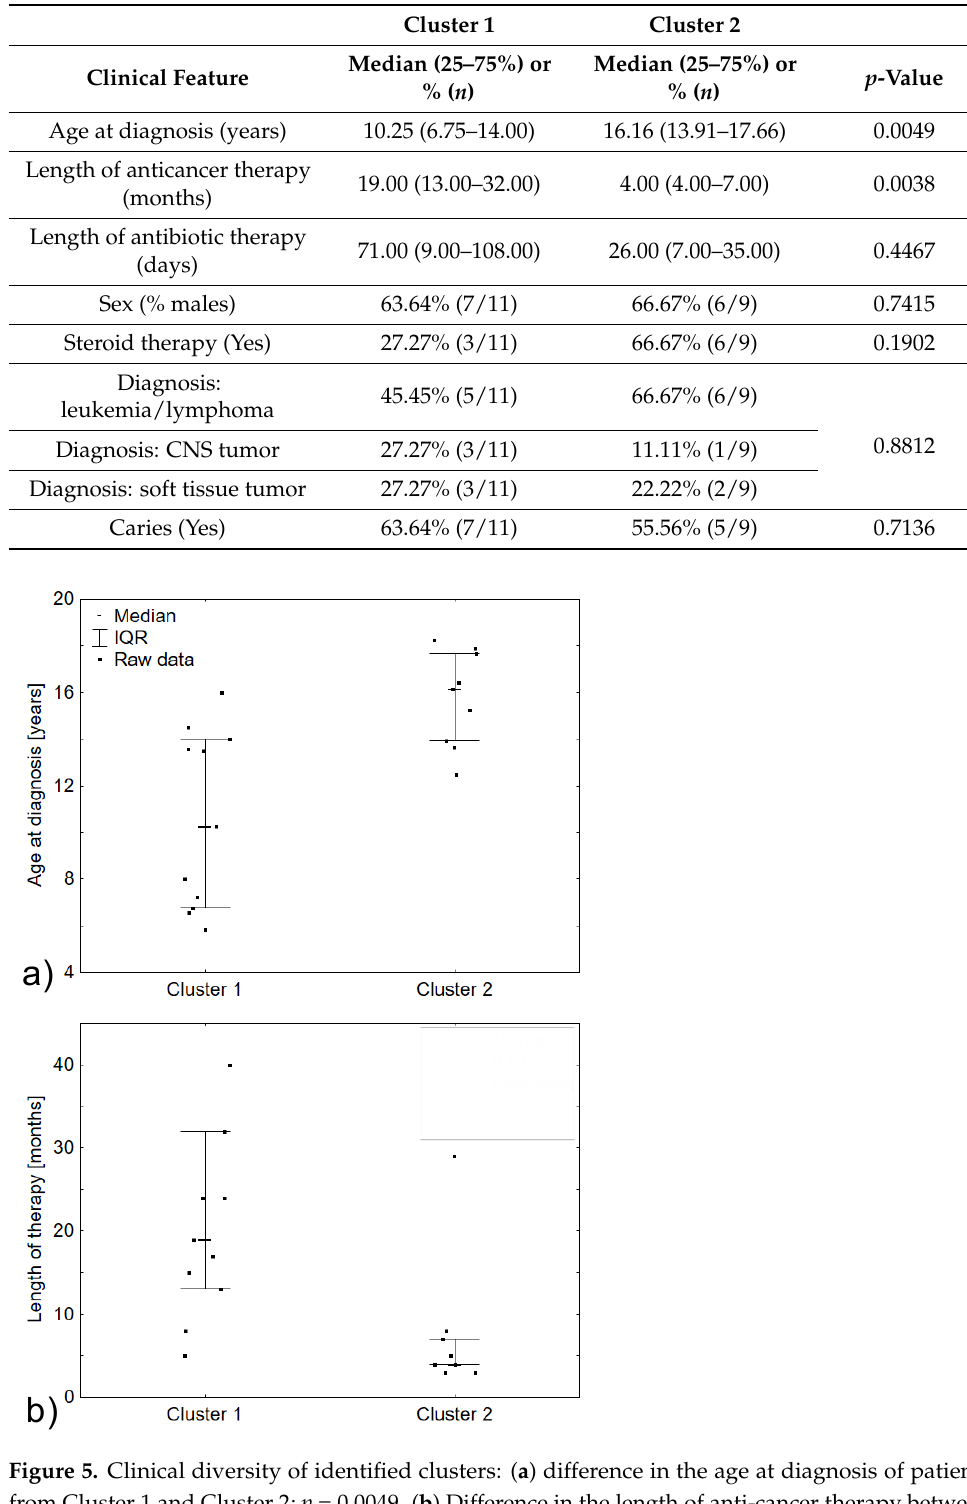
Table 4. Clinical characteristics of the patients according to the cluster adherence.